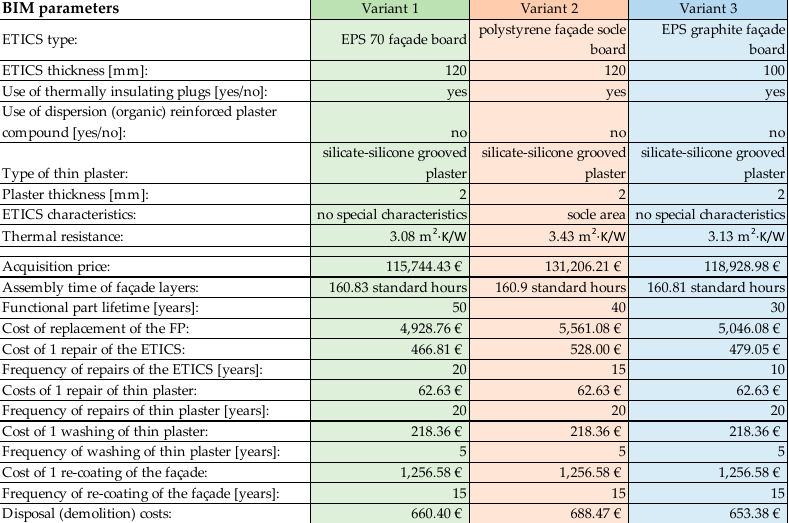
Figure 8. A showcase of information output transferrable to the BIM model.